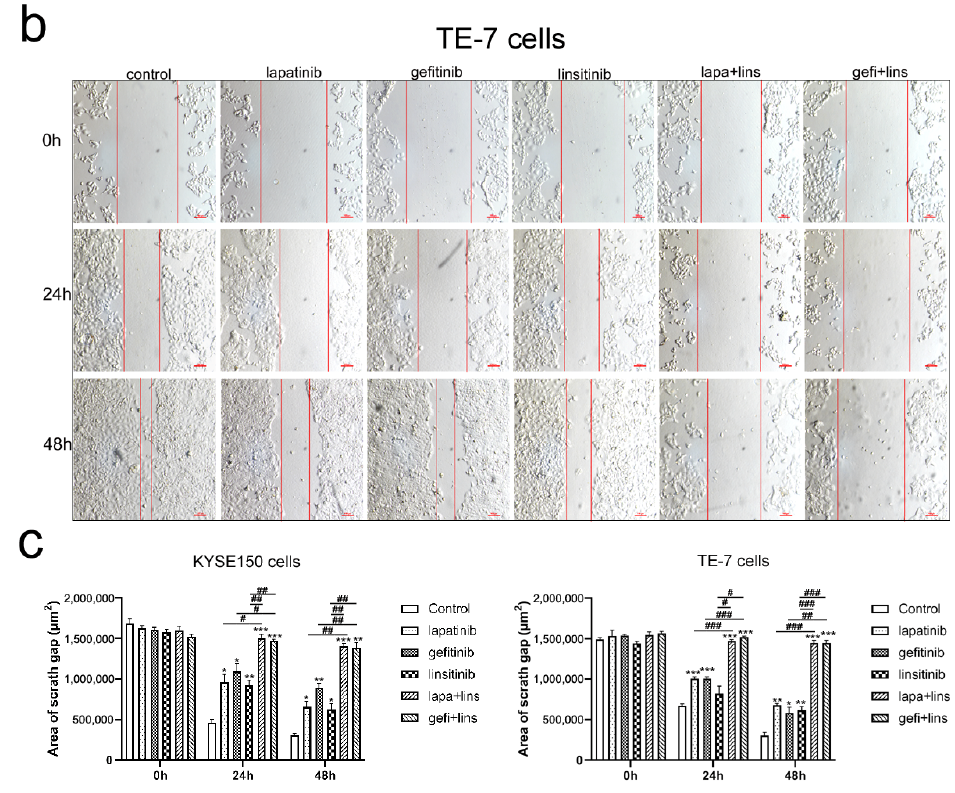
Figure 3. The effects of lapatinib, gefitinib, and linsitinib alone or in combination on the migration of KYSE150 and TE-7 cells detected by the wound healing assay. ( a , b ) Representative images of KYSE150 and TE-7 cells. ( c ) Quantification of the area of the scratch of KYSE150 and TE-7 cells by ImageJ. Margins of the scratch gap are indicated with red lines. Scale bars, 100 µ m. Statistical significance was calculated based on three independent experiments. * p < 0.05, ** p < 0.01, *** p < 0.001 vs. control. # p < 0.05, ## p < 0.01, ### p < 0.001 between depicted